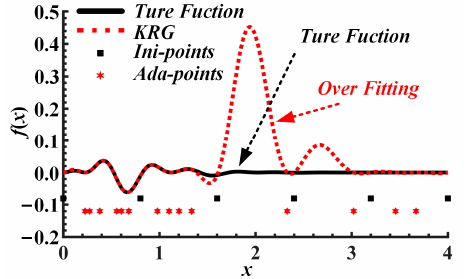
Figure 4. Overfitting of dynamic global approximate model.